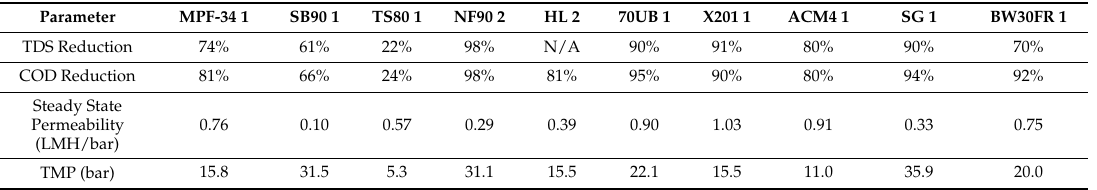
Table 2. Performance data for nanofiltration and reverse osmosis membranes used in the study. Parameter